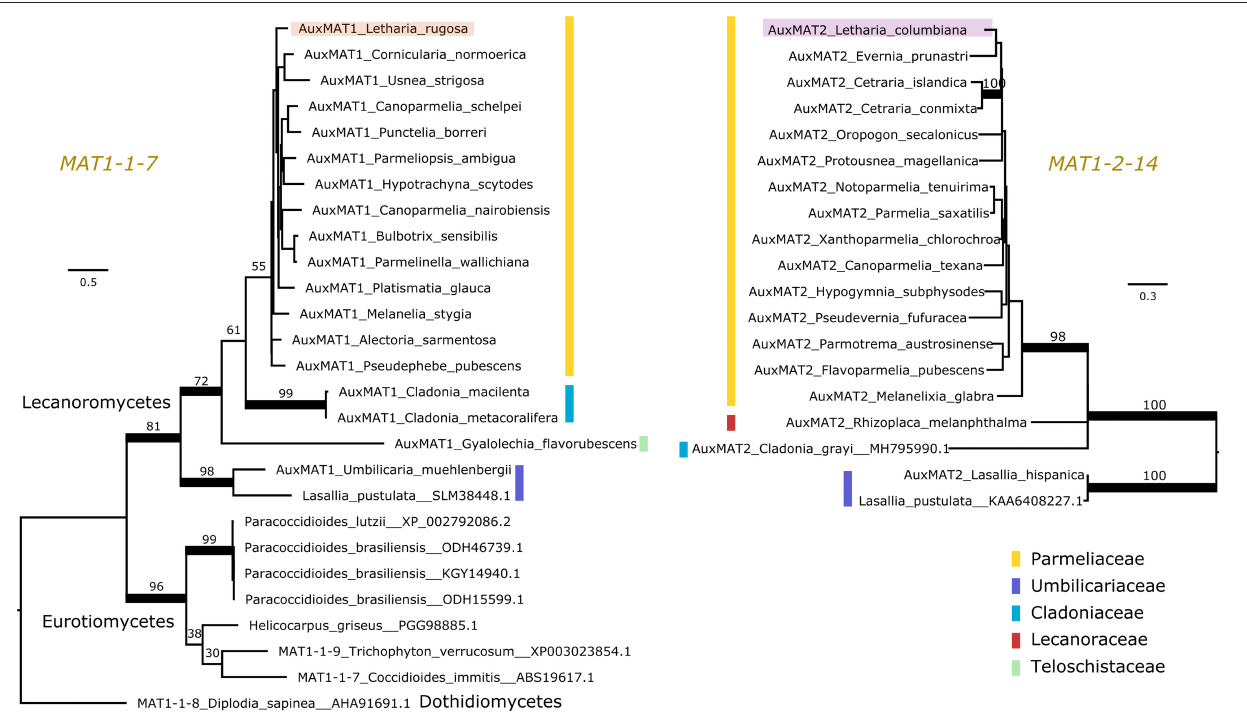
FIGURE 3 | Maximum likelihood trees of the auxiliary genes MAT1-1-7 (Left) and MAT1-2-14 (Right) . Colored vertical bars mark the different families within the lichen-forming class Lecanoromycetes, and the Letharia sequences are highlighted. MAT1-1-7 is found outside Lecanoromycetes, while MAT1-2-14 seems unique for this class. Notice that the homologous genes of MAT1-1-7 in Trichophyton verrucosum and Diplodia sapinea have been named differently by other authors. Branches with bootstrap values above 70% are thickened. Branch lengths are proportional to the scale bar (amino acid substitution per site).